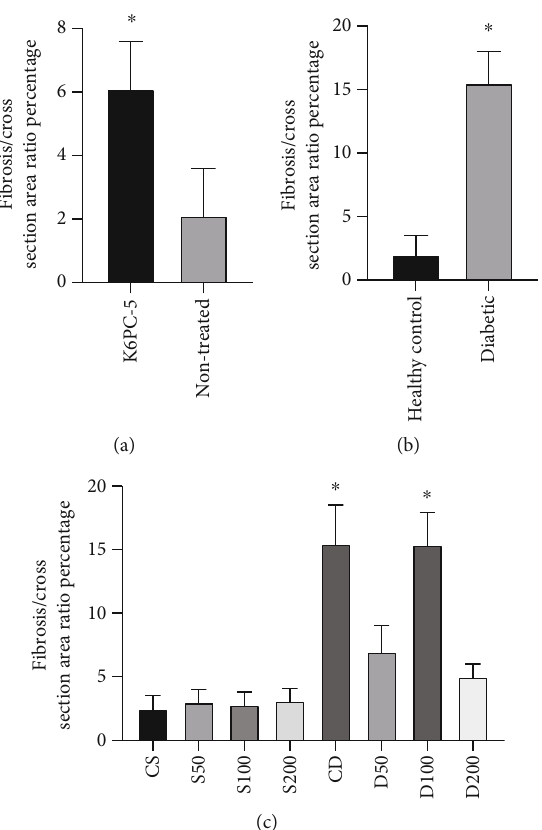
Figure 2: Percentage of fi brosis area/tissue crossarea ratio of studied rats. ∗ p < 0 : 05 , comparison of fi brosis percentage per cross-section area. Results are the average of 5 di ff erent tissue sections for each rat. (a) K6PC-5 rats have higher fi brosis tissue than nontreated rats. (b) Diabetic rats have higher fi brosis tissue than healthy control rats. (c) Pairwise comparison of di ff erent doses of aminoguanidine-treated diabetic rats, and CD and D100 rats have signi fi cantly more fi brotic cardiac tissue than other